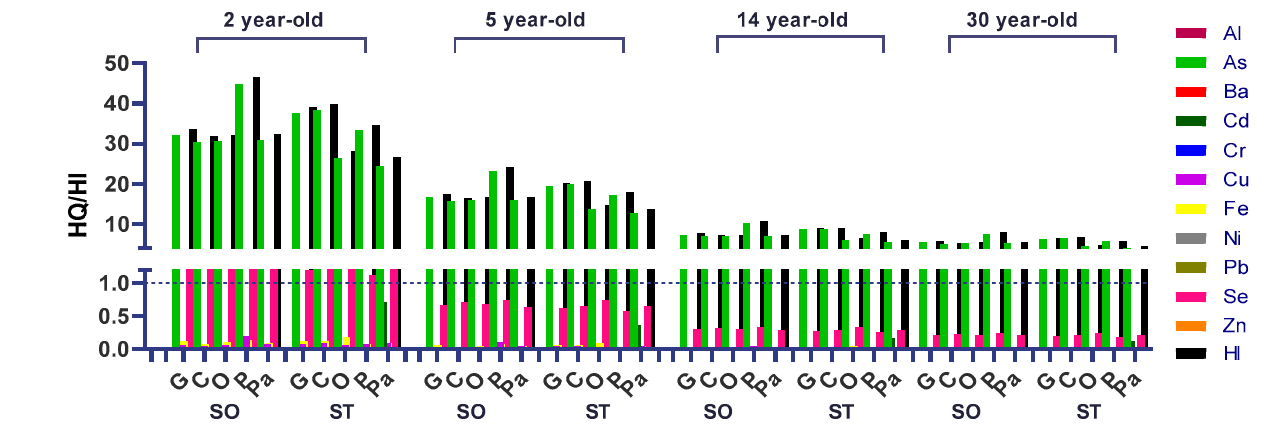
8 of 17 Figure 1. Elemental content distribution in canned sardines quantified by ICP OES. Iron was the most predominant element detected across all samples. Other prevalent metal(loids) were selenium and arsenic. The sample SO-O had a divergent elevated bar- ium amount. 3.3. Human Health Risk Assessment